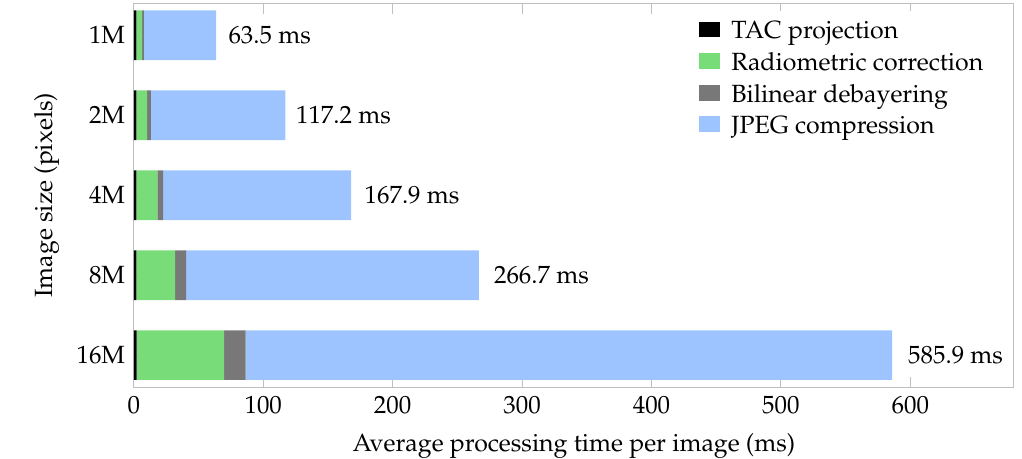
Figure 10. Processing times for real-time processing chain (airborne segment), depending on image size. Results from processing an aerial image dataset comprising 1206 single images, captured by three different camera sensors, each with a 16 MPix Bayer pattern sensor. JPEG compression by libjpeg -library version 9b; radiometric depth: 12-bit; and quality setting: 5. Processing machine: standard desktop computer with an Intel i7-6800K CPU. The different image sizes were obtained by vertical symmetric cropping of original (full)